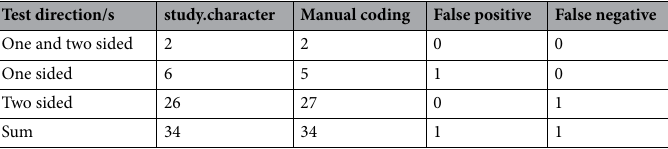
Table 10. Absolute detections of test direction/s.